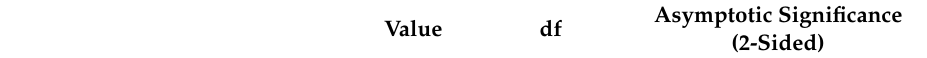
Table 3. The results of chi-square bivariate